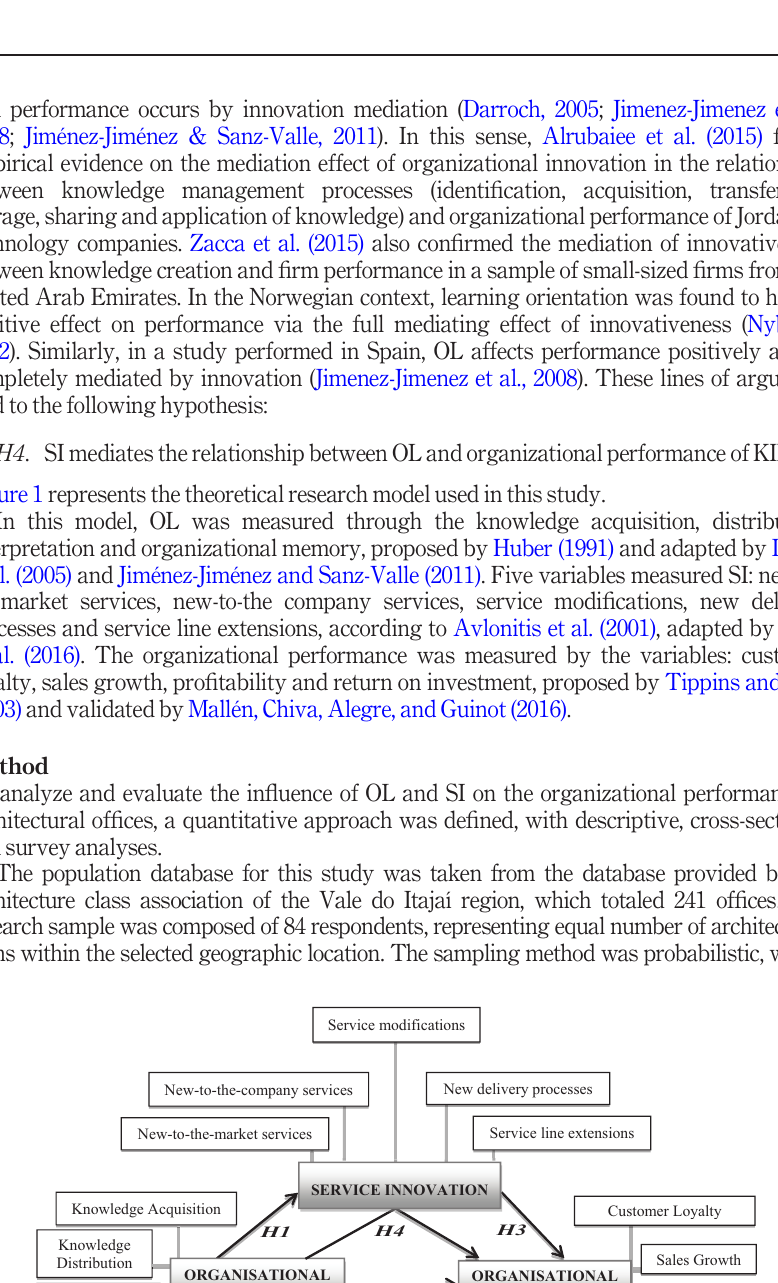
Figure 1. Relationship among OL, SI and